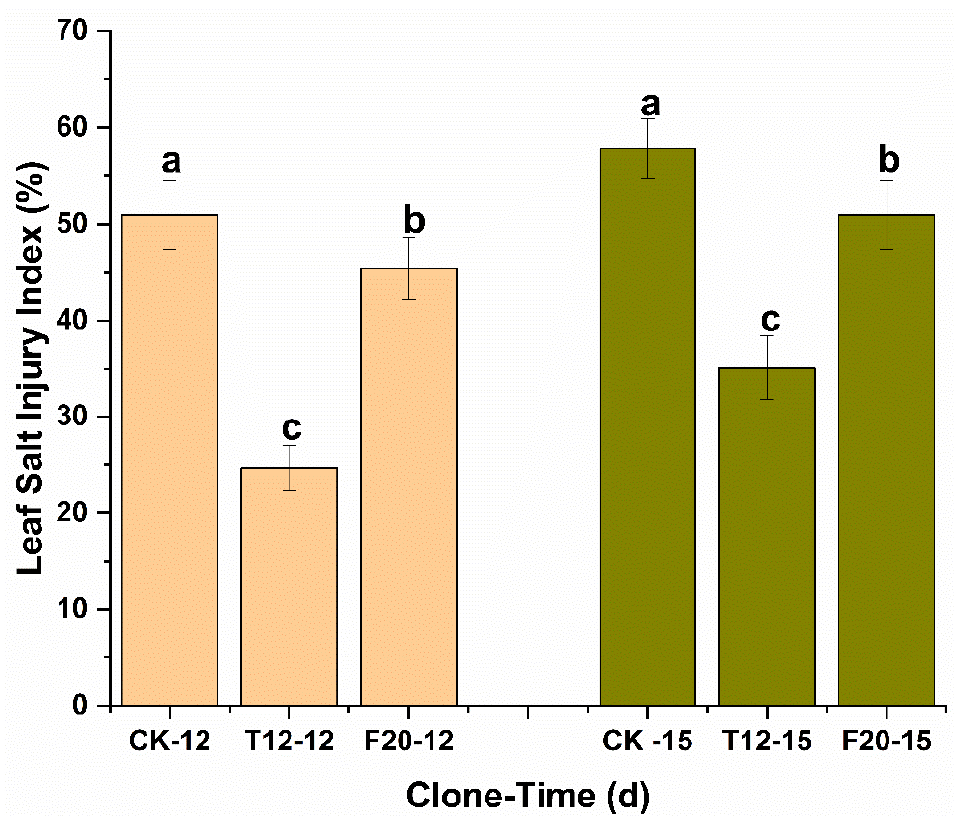
Figure 2. Leaf salt injury index of CK, T12, and F20. CK-12, T12-12, and F20-12 indicate the leaf salt injury index of CK, T12, and F20 on the 12th day after salt stress treatment; CK-15, T12-15, and F20-15 indicate the leaf salt injury index of CK, T12, and F20 on the 15th day after salt stress treatment.